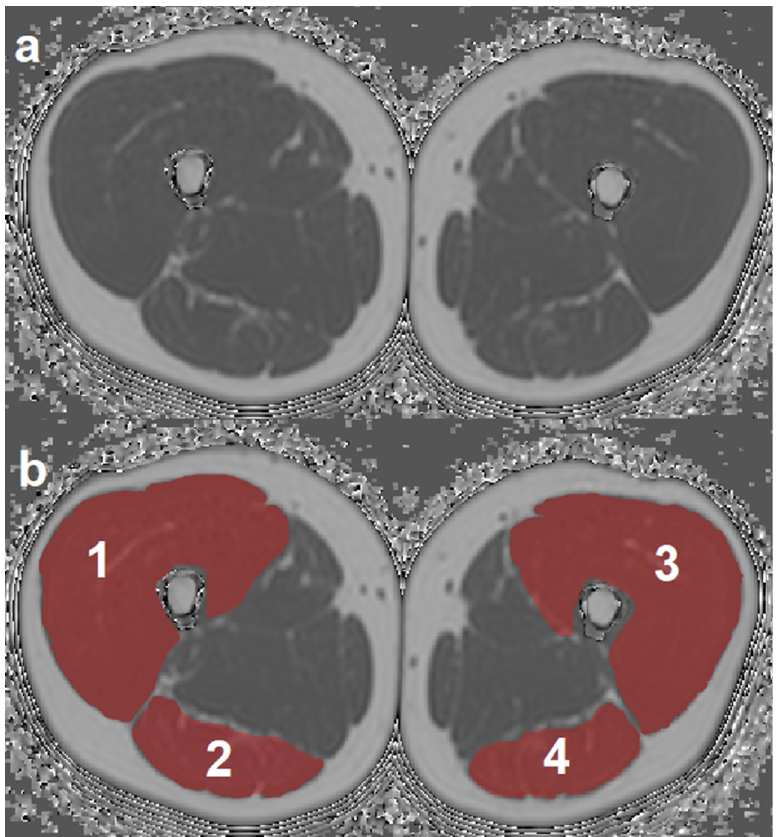
Figure 1. Representative axial PDFF map ( a ) with overlays of the four segmented muscle ROIs ( b ). 1 : right quadriceps muscle, 2 : right ischiocrural muscles, 3 : left quadriceps muscle, 4 : left ischiocrural muscles. (PDFF, proton density fat fraction; ROI, region of interest).